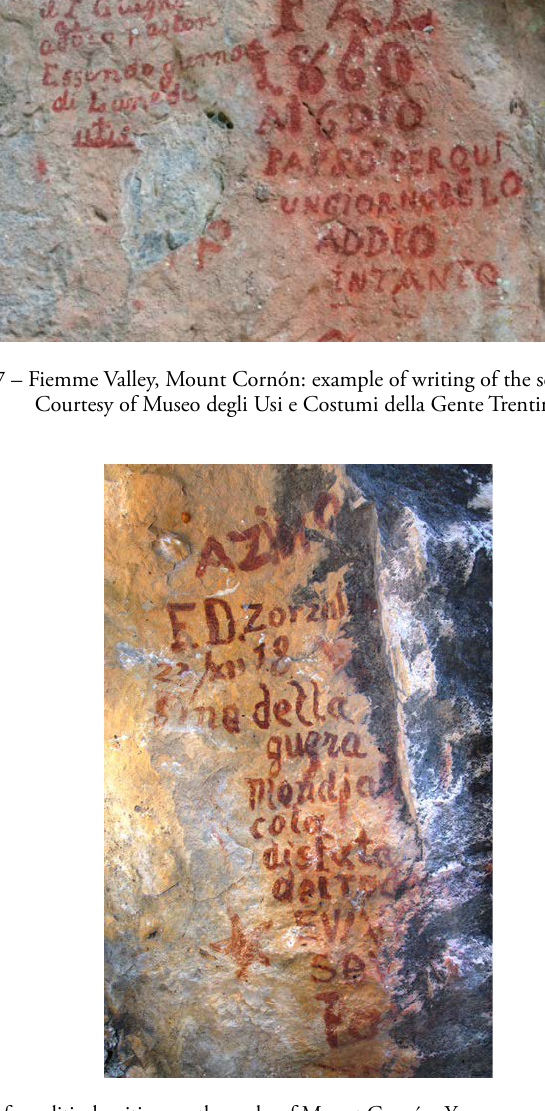
Figure 7a – Example of a political writing on the rocks of Mount Cornón. You can read: ‘ AZINO F.D. Zorzalin 23/ XII 18 [.]fine della guera mondiale cola disfata dei Todesci EVIVA SAV[.] Po[.] ’ (‘end of the world war with the defeat of the Germans HURRAY’. On the top of the writing someone else wrote: donkey). Courtesy of Museo degli Usi e Costumi della Gente